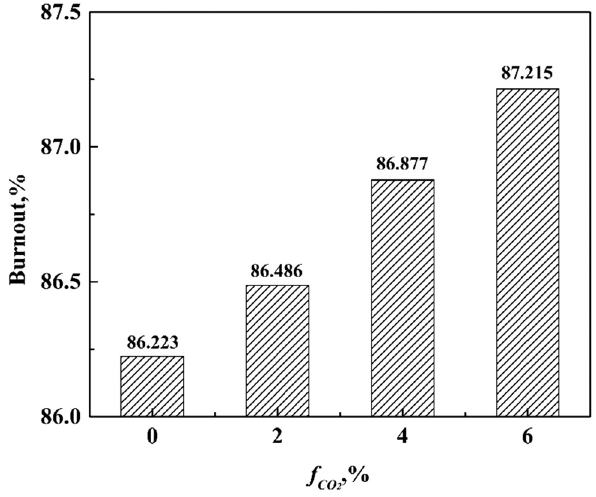
Figure 10: Pulverized coal burnout of outlet section under di ff erent in the hot f CO 2